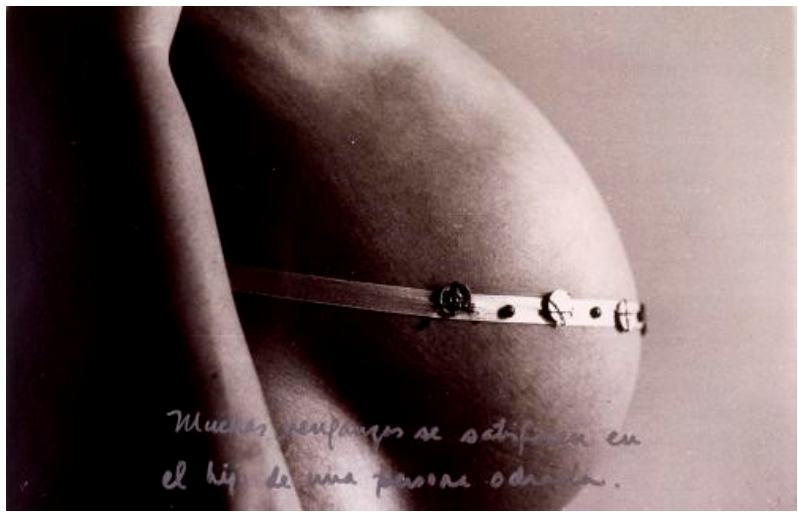
Figure 4. Marta María Pérez Bravo, Muchas venganzas se satisfacen en el hijo de una persona odiada